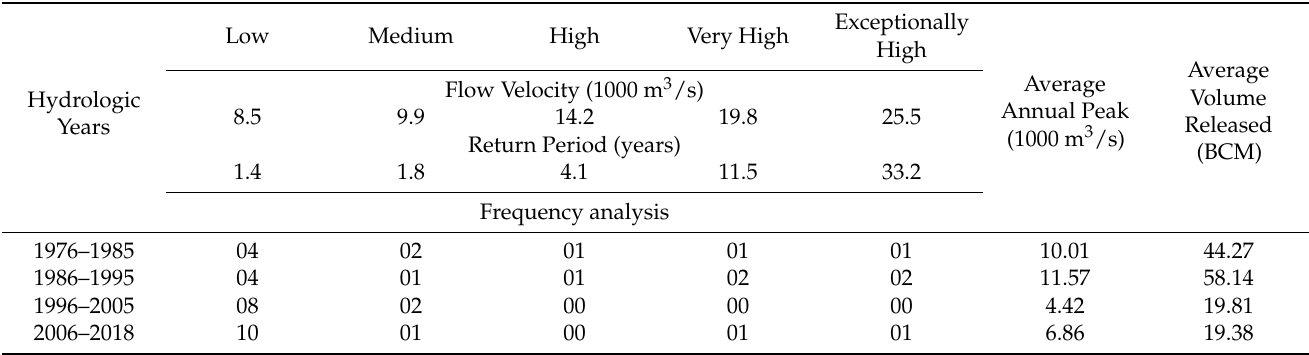
Table 2. Categorized flood peaks occurrence and water escape pattern below the Kotri